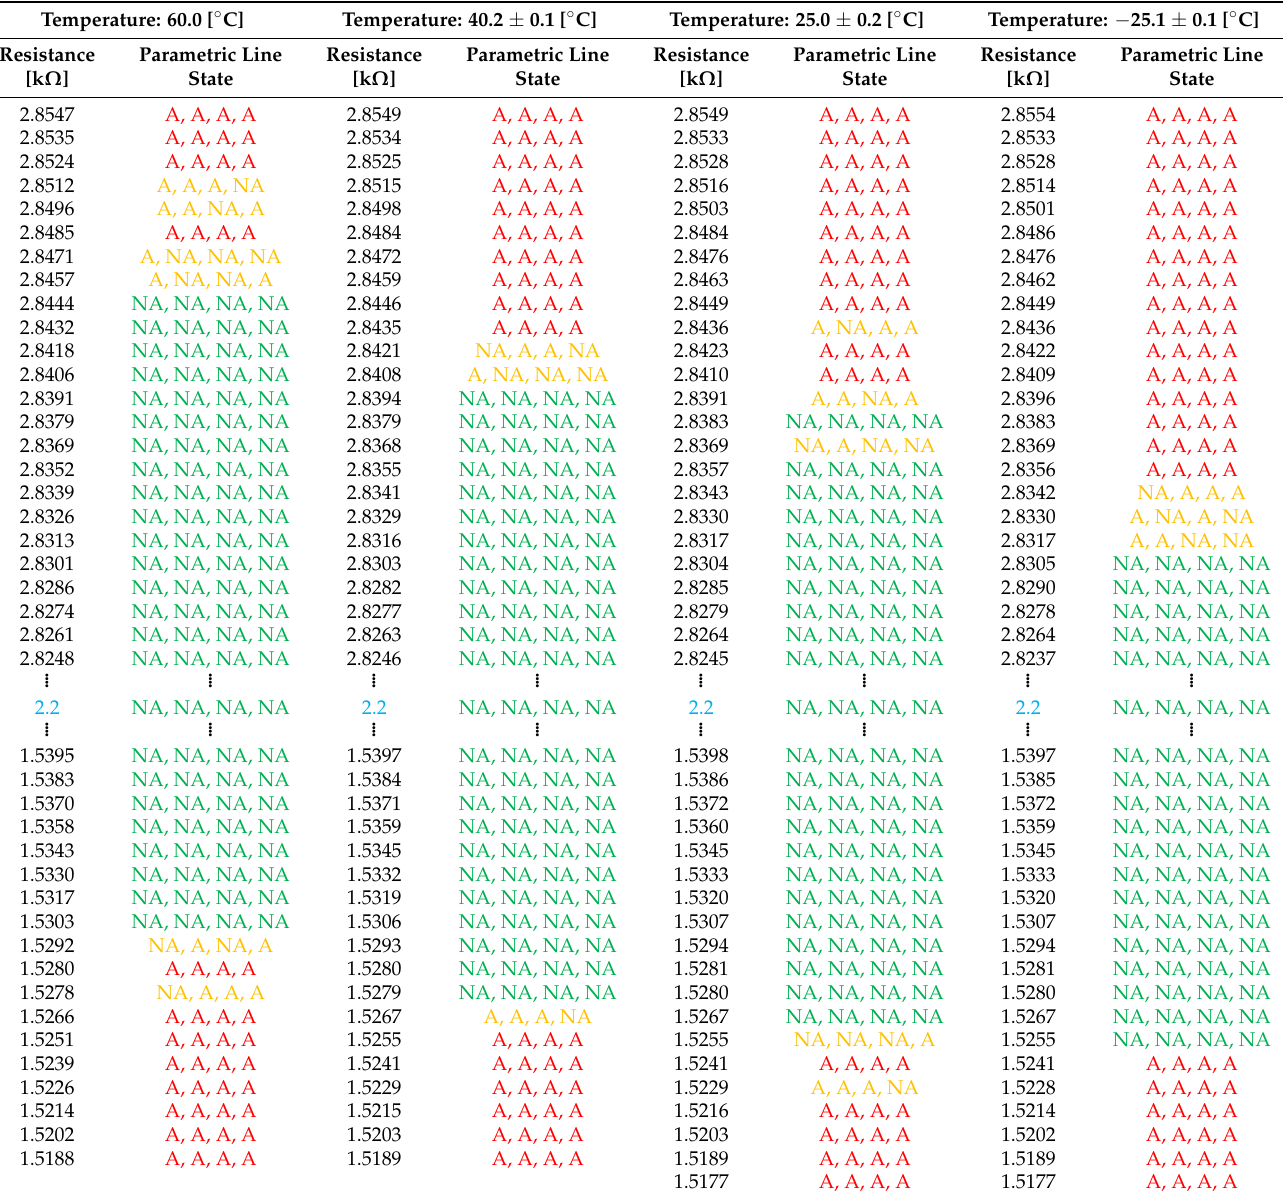
Marking in the Table 4: A-Alarm, NA-No Marking in the Table 4: A-Alarm, NA-No Alarm. Marking in the Table 4: A-Alarm, NA-No Alarm. Marking in the Table 4: A-Alarm, NA-No Alarm. Marking in the Table 4: A-Alarm, NA-No Alarm. Marking in the Table 4: A-Alarm, NA-No Alarm. Marking in the Table 4: A-Alarm, NA-No Alarm.